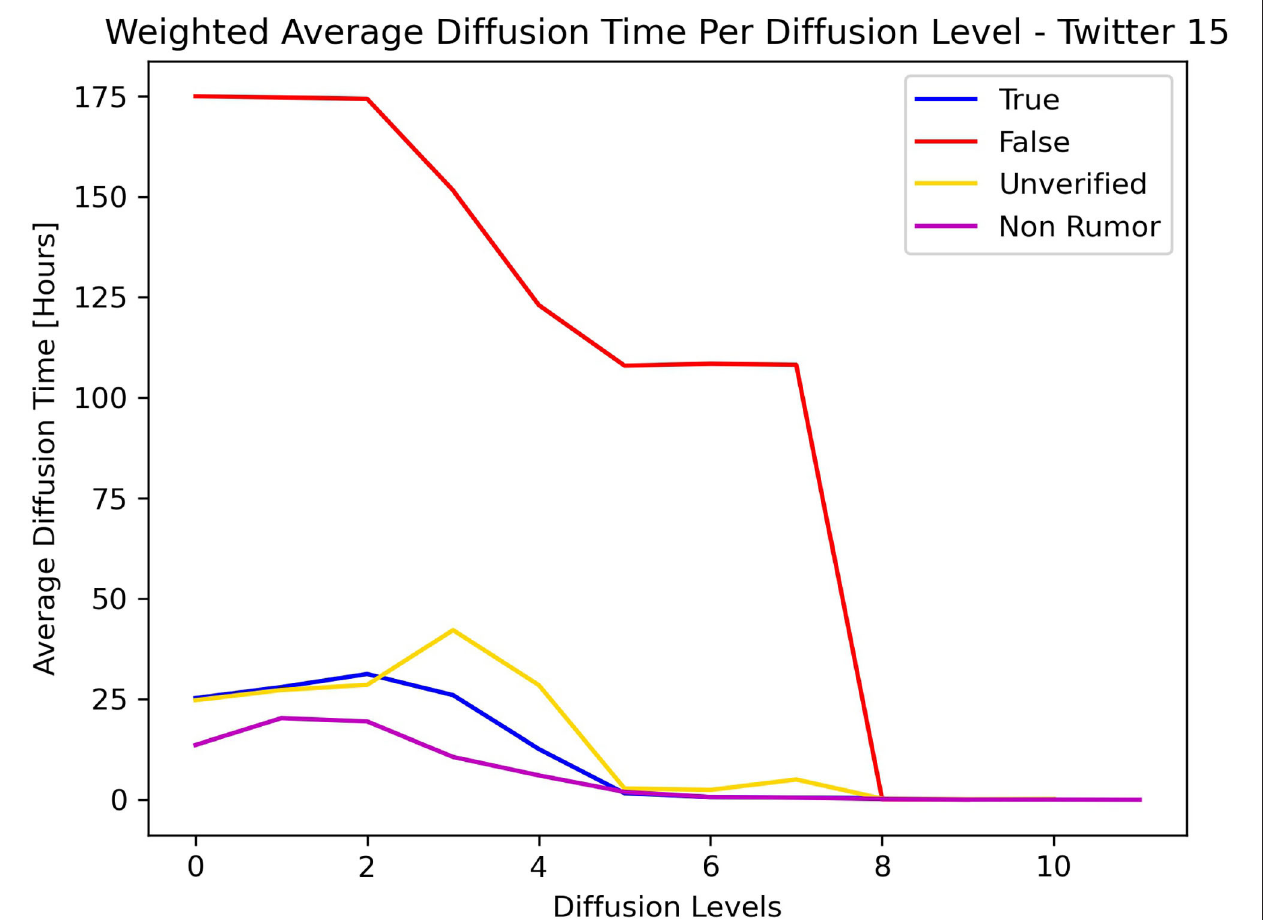
FIGURE 5 | Weighted average diffusion time per diffusion